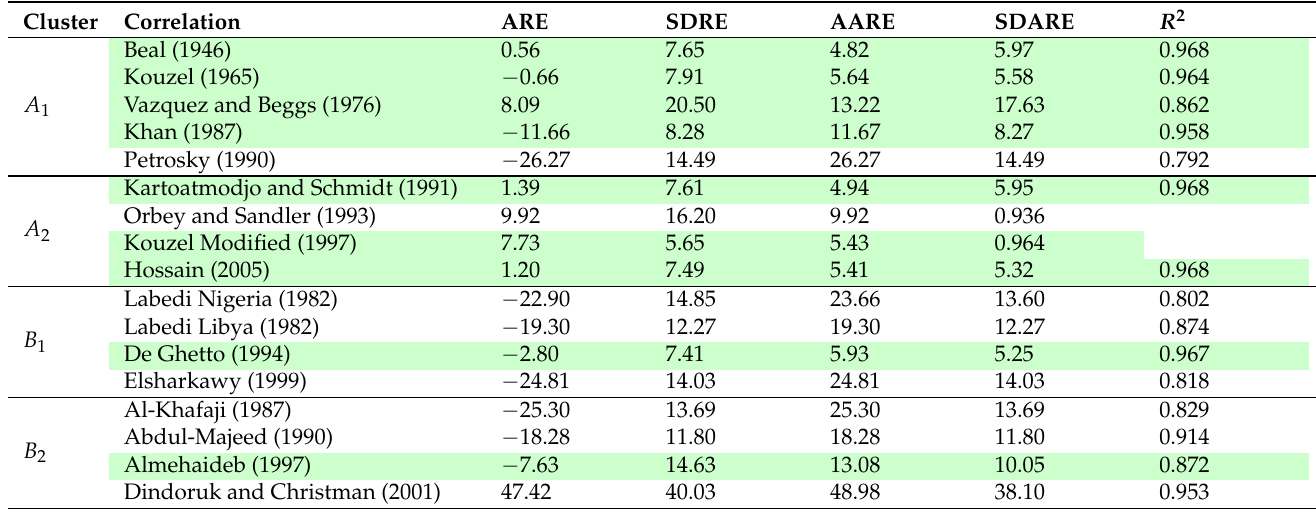
Table A4. Detailed metric values for all correlations and for µ ob range